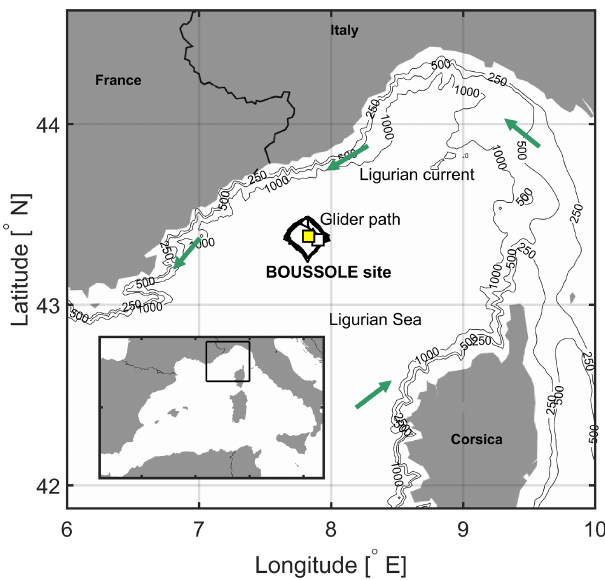
Figure 1. The area of the northwestern Mediterranean Sea show- ing the French Riviera and Italian Riviera, the island of Corsica, the main current branches (green arrows) in the Ligurian Sea, and the locations of the BOUSSOLE buoy (white square) and the Azur meteorological buoy (yellow square). The black line indicates the glider’s path in March–April